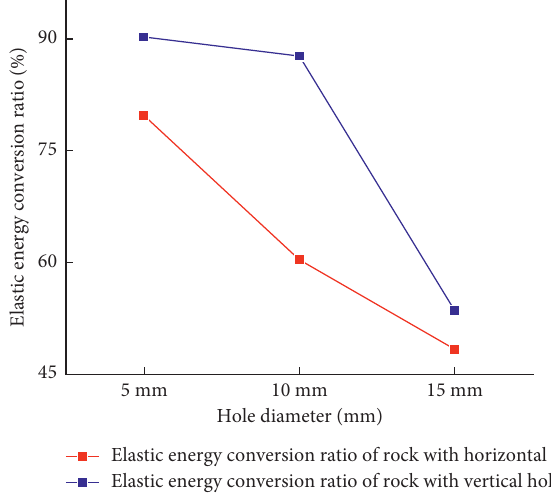
Figure 8: Elastic energy conversion ratio of the rock with different hole